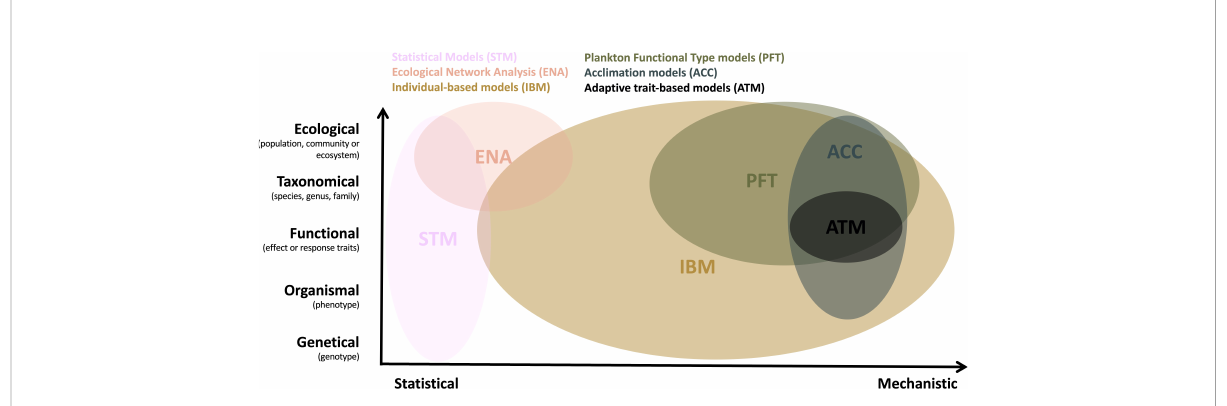
FIGURE 1 Six modelling approaches commonly used to capture various dimensions of plankton biodiversity. We further organize the modelling approaches along an axis spanning from those models that require explicit descriptions of ecological or biological processes (mechanistic) to those methods that do not